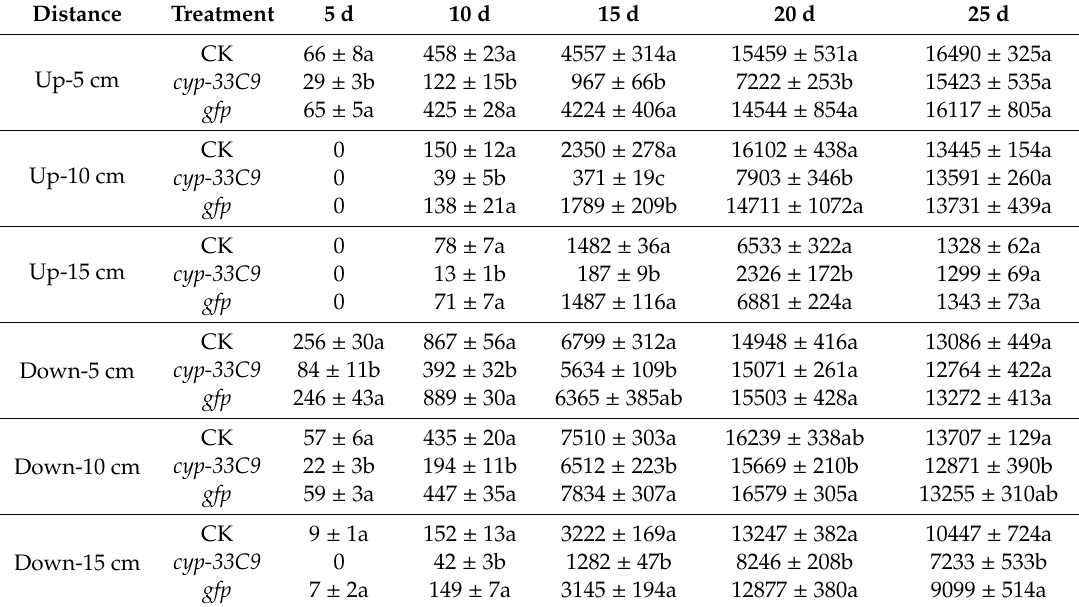
Table 1. E ff ects of RNA interference on migration and reproduction of Bursaphelenchus xylophilus after inoculation into Pinus